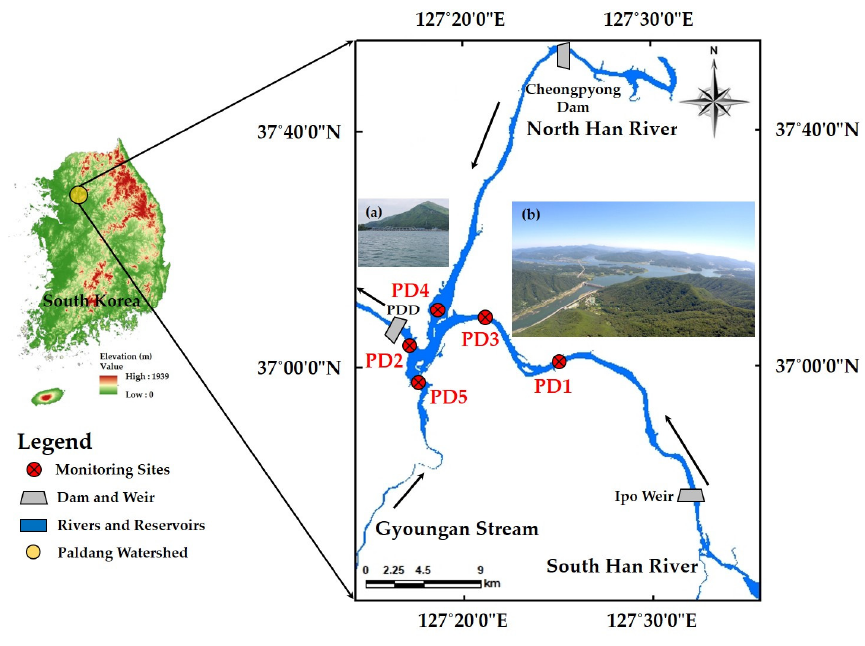
Figure 1. Map showing water quality monitoring network sites in the Paldang Reservoir (PDR), South Korea. ( a ) Paldang hydroelectric dam (PDD); ( b ) panoramic view of the PDR.